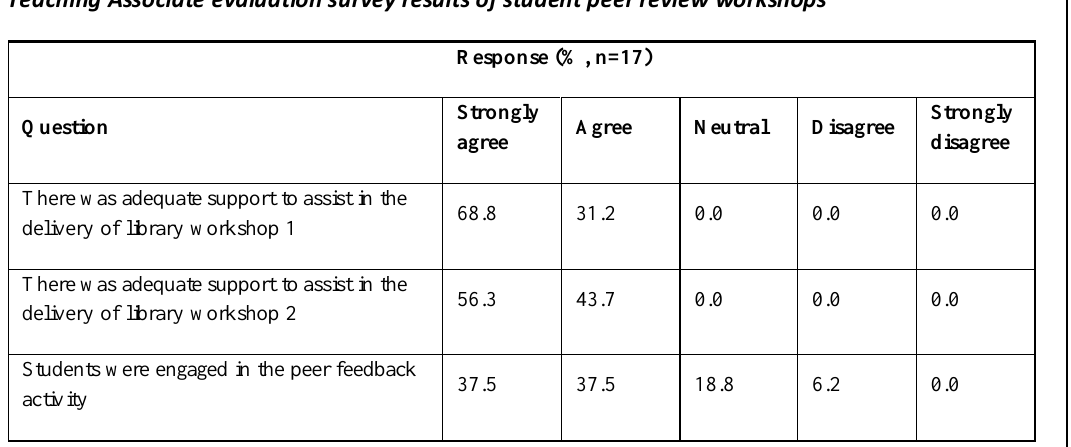
Teaching Associate evaluation survey results of student peer review